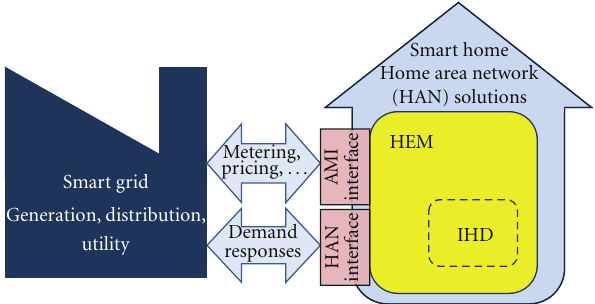
Figure 1: Realizing smart grids in smart